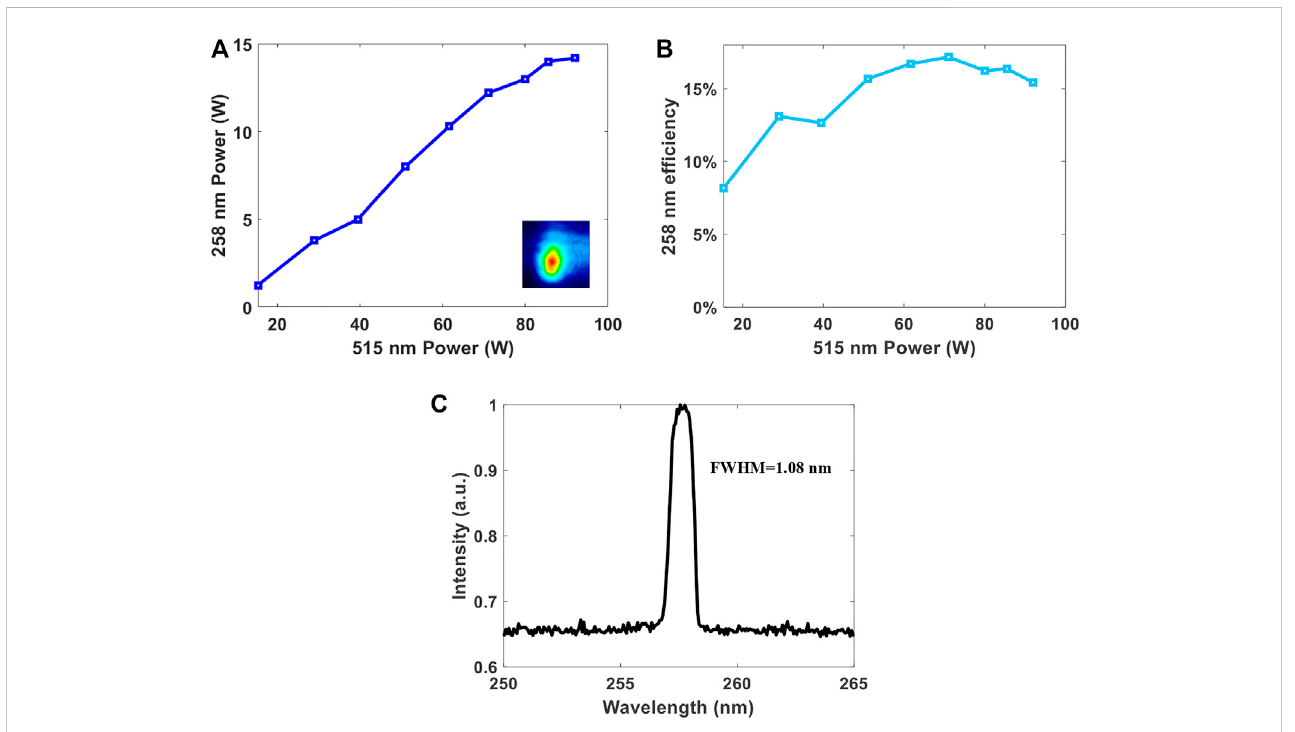
FIGURE 3 Average power (A) and conversion ef fi ciency at 258 nm (B) versus the average pump laser power at 515 nm. Inset shows the 258-nm beam pro fi le. (C) Spectrum of the 258-nm laser with a FWHM of 1.08